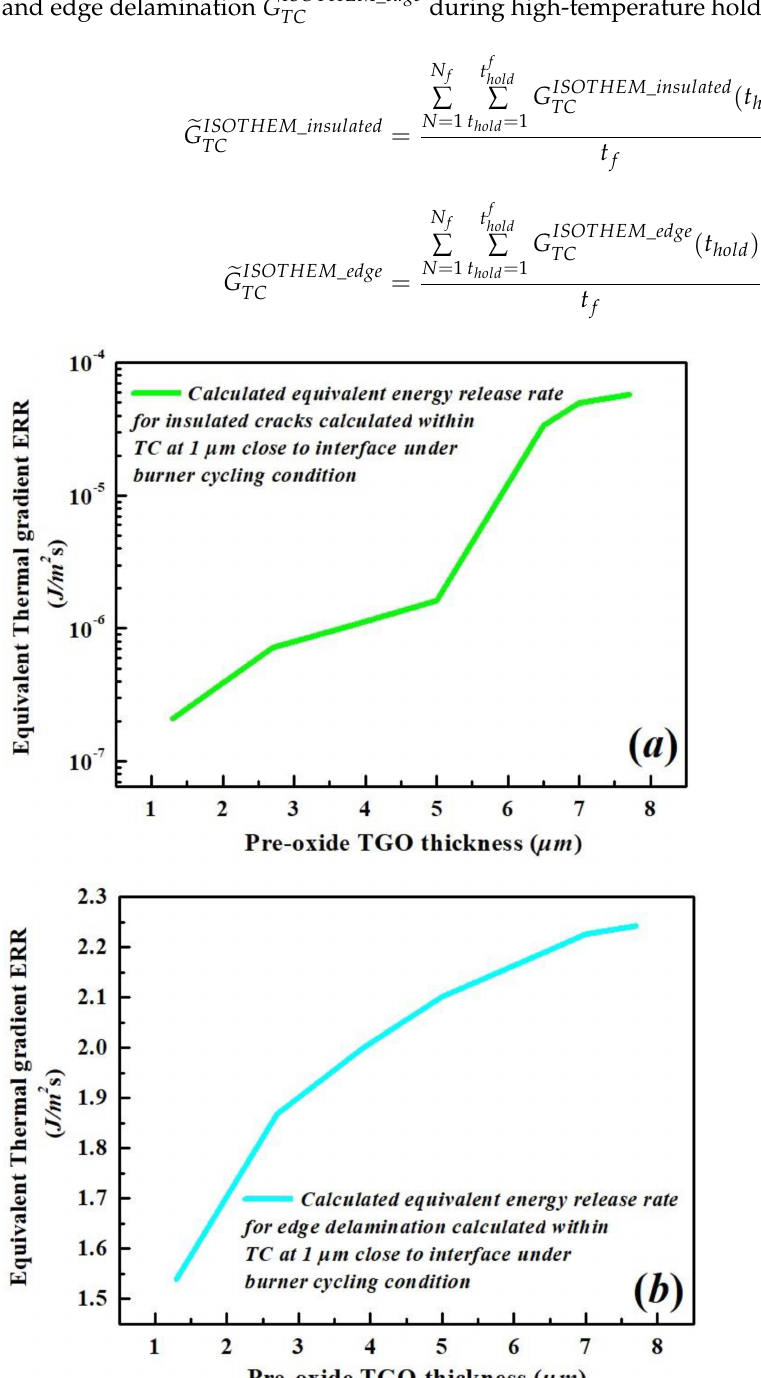
Figure 13. The equivalent thermal gradient ERR vs. the pre-oxide TGO thickness under burner cycling condition assuming ( a ) insulated cracks and ( b ) edge delamination crcaks within